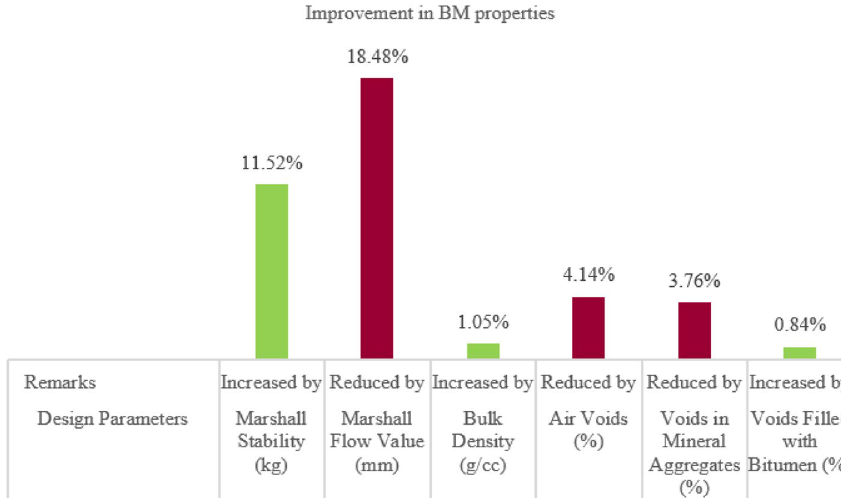
Fig. 32 Enhancement in the properties of modified